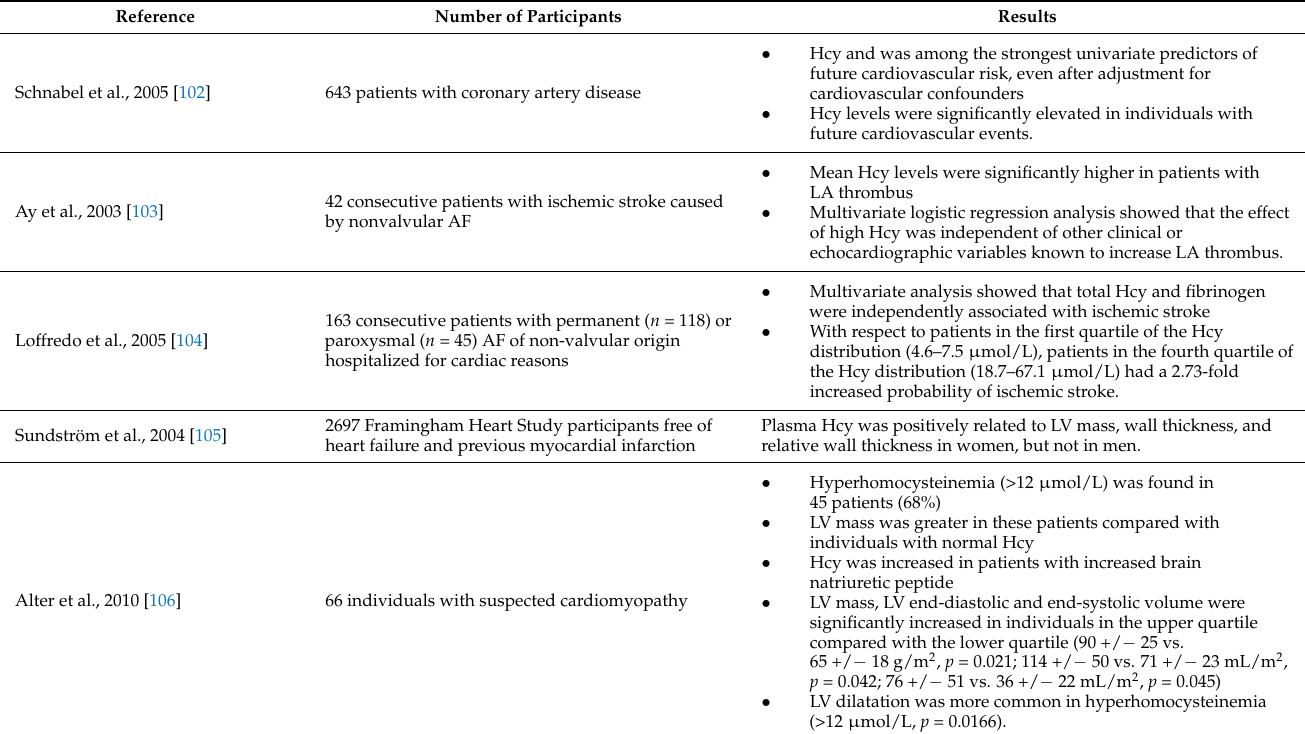
Table 3. Studies reporting available clinical data regarding the connection between Hcy and